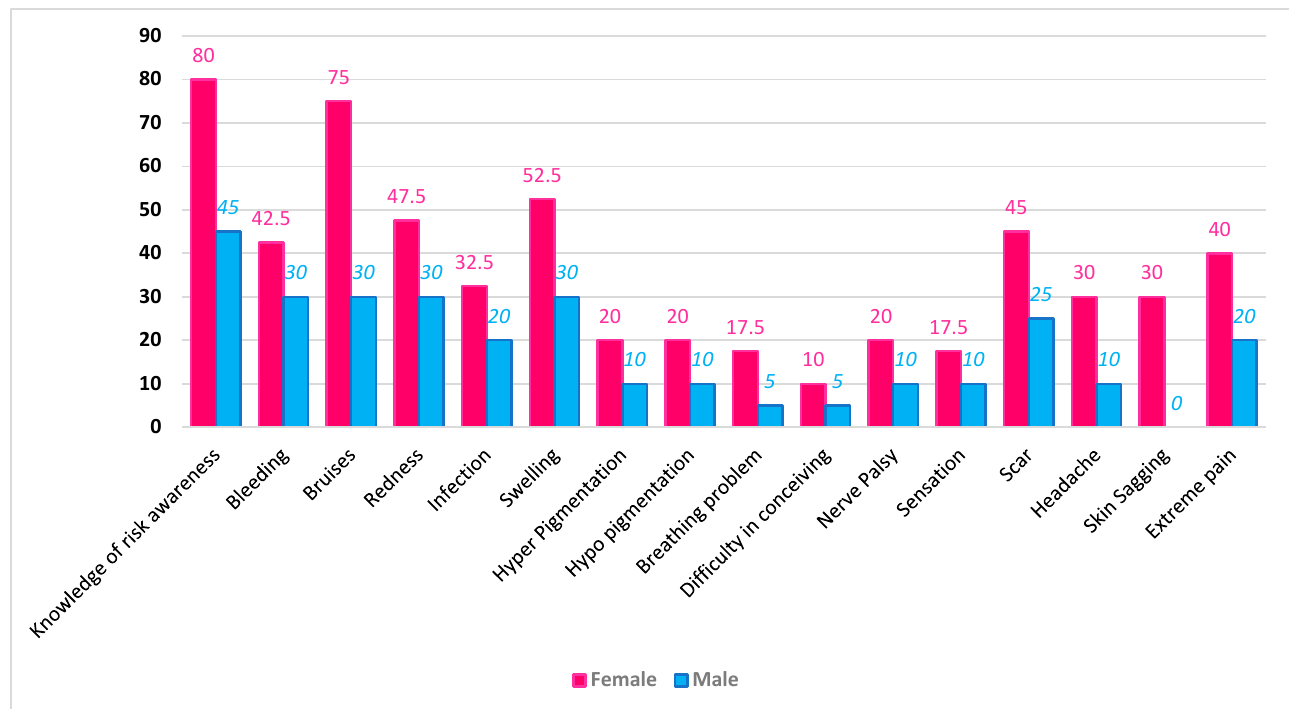
Figure 5. Participants’ awareness regarding the risk factors associated with cosmetic procedures.